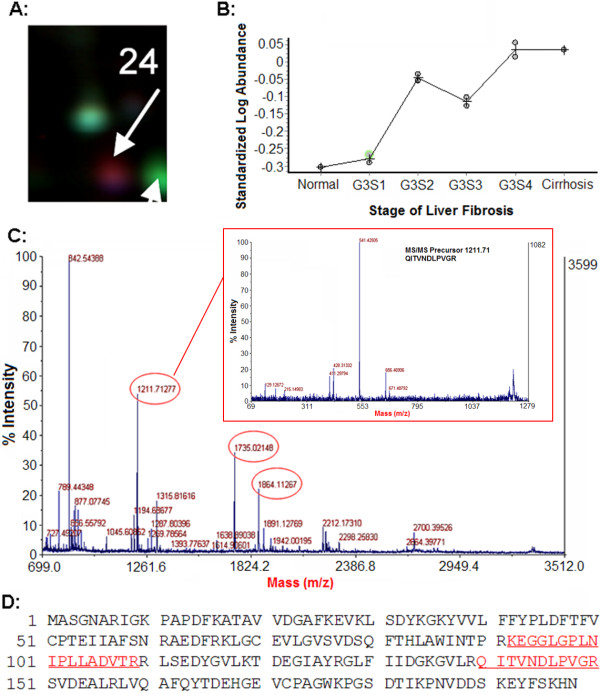
Plasma Prx II levels were up-regulated with fibrosis progress. A: Magnified region of DIGE gel image of Prx II. B: The patterns of the relative abundance alterations of Prx II in different groups. C: The MALDI-TOF MS map of Prx II, in which peptide peaks for further MS/MS identification are labeled out with mass value and the MS/MS map of peptide 1121.71 was shown. D: The amino acid sequences of Prx II, in which MS/MS matched peptide sequences, are underlined.